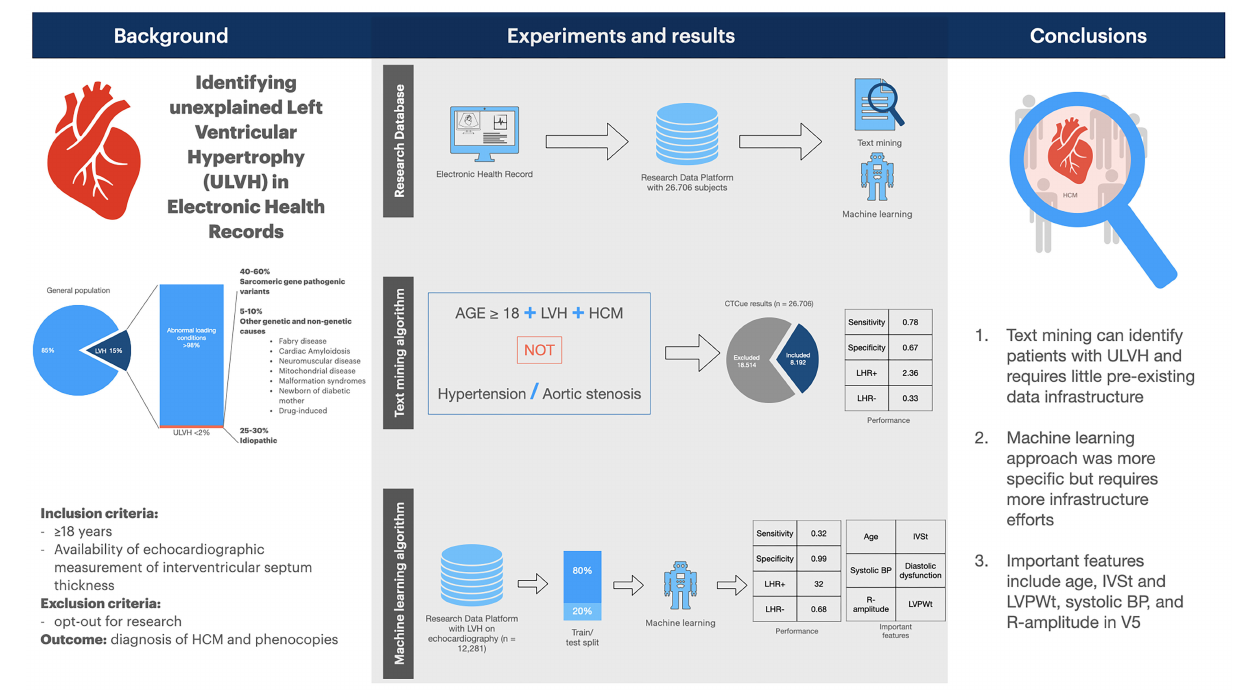
FIGURE 3 | Summary figure. Summary figure of the study. BP, blood pressure. IVSt, interventricular septum thickness; LVH, left ventricular hypertrophy; LVPWt, left ventricular posterior wall thickness; LHR, likelihood ratio; ULVH, unexplained